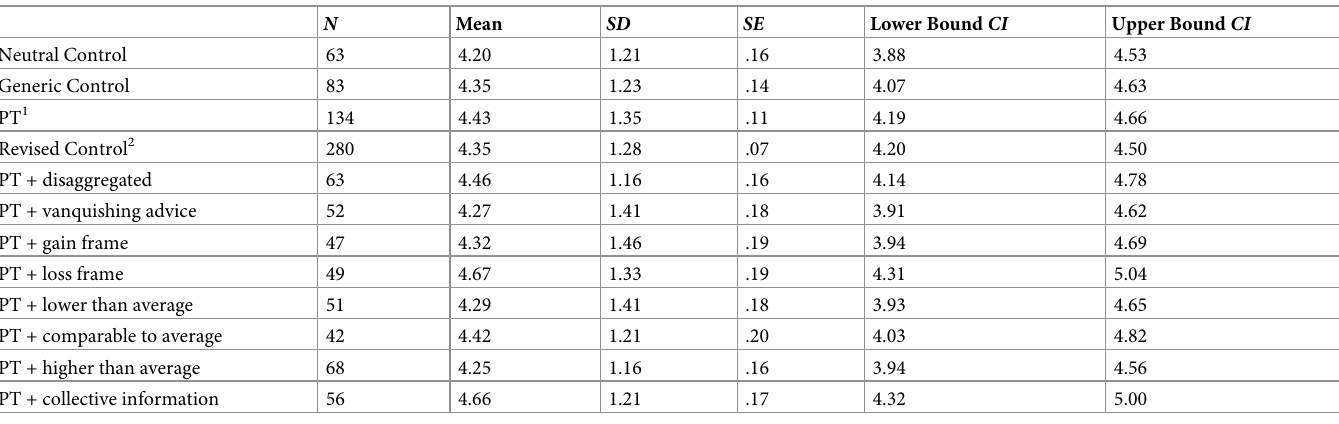
Table 1. Behavioural intention to vanquish energy vampires scores per